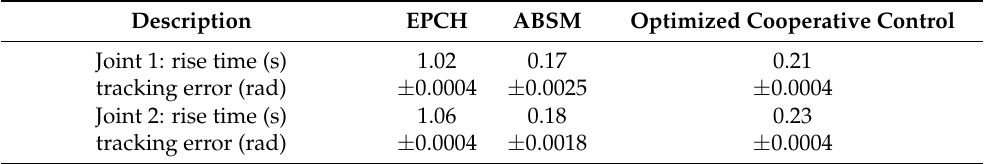
Table 5. Property indicators of EPCH, ABSM, and optimized cooperative control with unit step re-